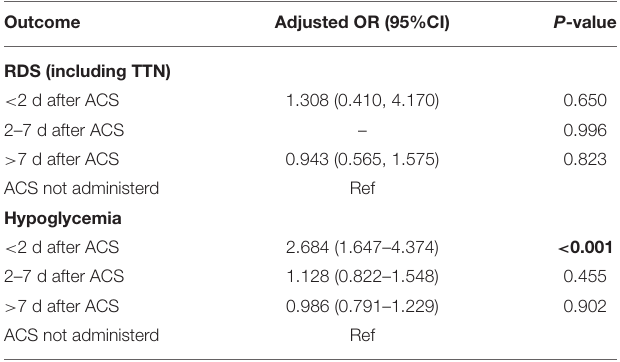
TABLE 5 | Association between time interval from antenatal corticosteroids administration to delivery and adverse neonatal outcomes. Outcome